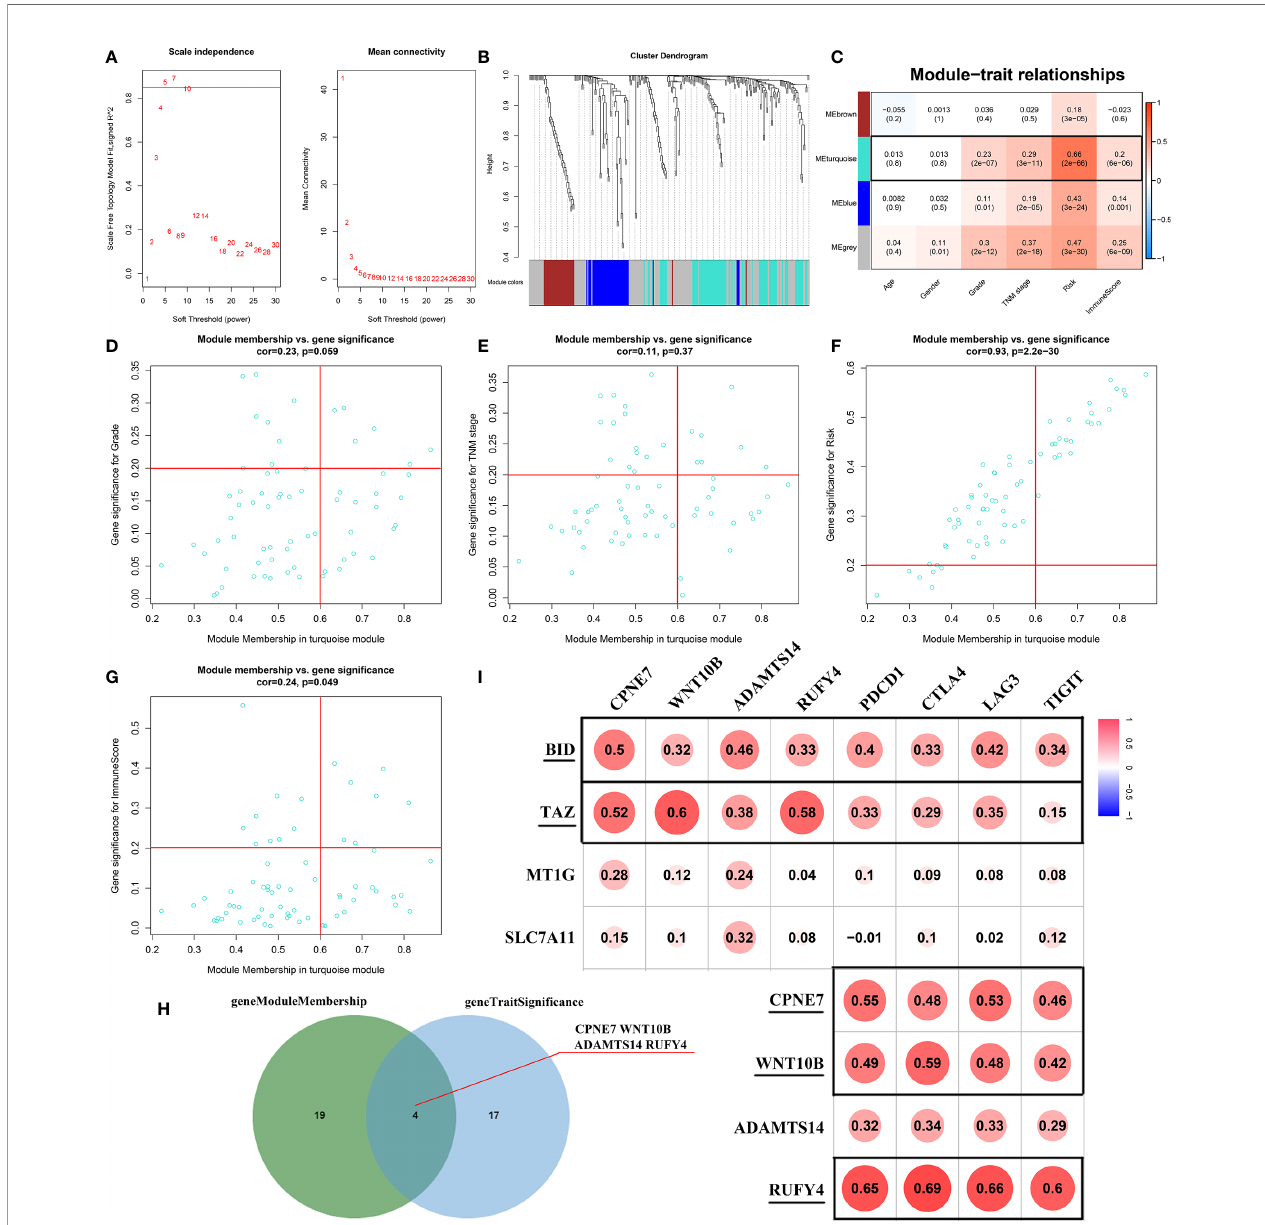
FIGURE 7 | Identi fi cation of key genes of regulating immune checkpoints. (A) Analysis of scale-free fi t parameter and mean connectivity for various soft-thresholding power. (B) Dendrogram of DEGs clustered based on a dissimilarity measure (1-TOM). The DEGs were divided into four modules (brown, turquoise, blue, and gray). (C) The correlation between clinical traits and modules. MEturquoise was selected as the hub module. (D – H) Four genes (CPNE7, WNT10B, ADAMTS14, and RUFY4) were regarded as downstream hub genes. (I) The correlation among the FeSig (BID, TAZ, MT1G, and SLC7A11), downstream hub genes (CPNE7, WNT10B, ADAMTS14, and RUFY4), and immune checkpoints (PD-1, CTLA4, LAG3, and TIGIT). BID, TAZ, CPNE7, WNT10B, and RUFY4 were selected for further analysis. DEGs, differentially expressed genes; TOM, topological overlap